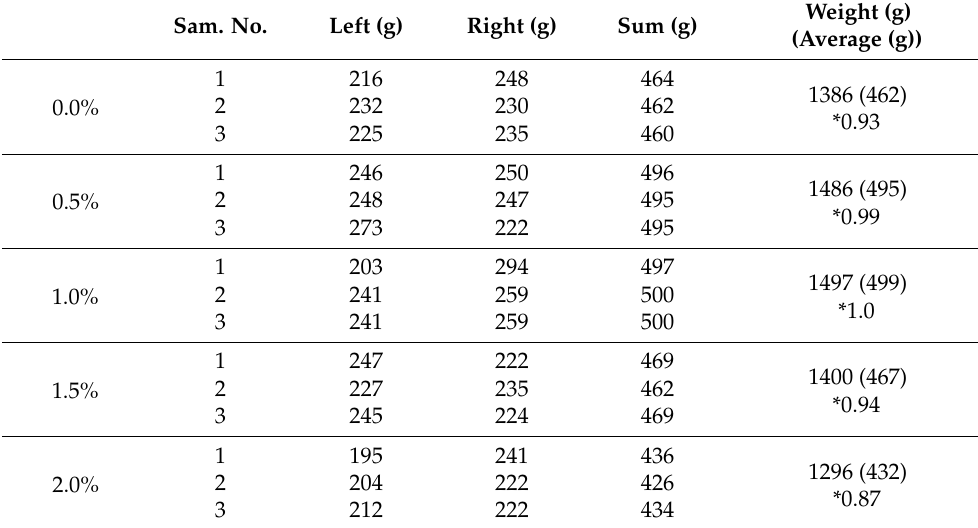
Weight (g) (Average (g))